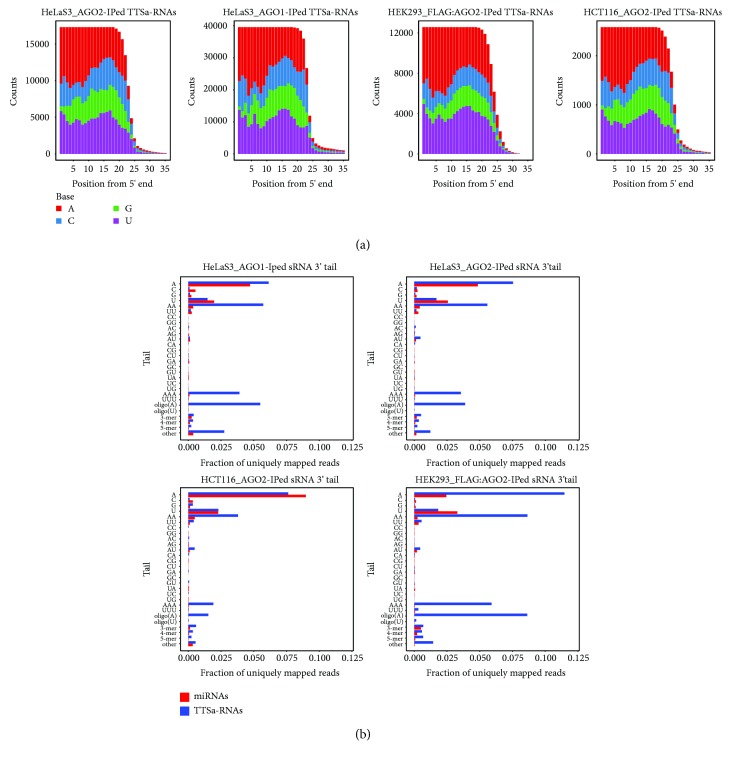
TTSa-RNAs display specific features in 5′ end nucleotide composition and in 3′ end tailing. (a) Nucleotide composition at each position of AGO-bound TTSa-RNAs in different cell lines. (b) 3′ end tail composition and frequency in AGO1- and AGO2-bound TTSa-RNAs (in blue) and miRNAs (in red) from HeLaS3 nuclear extracts, in AGO2-associated TTSa-RNAs and miRNAs in HCT116 nuclear lysate, and in FLAG:AGO2-bound TTSa-RNAs and miRNAs from HEK293T whole cell extracts.